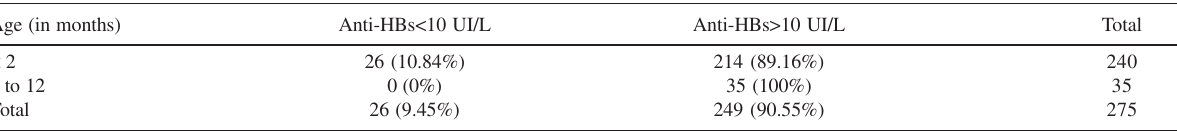
Table 3 - Age at the first HBV vaccine dose versus seroconversion Age (in months)